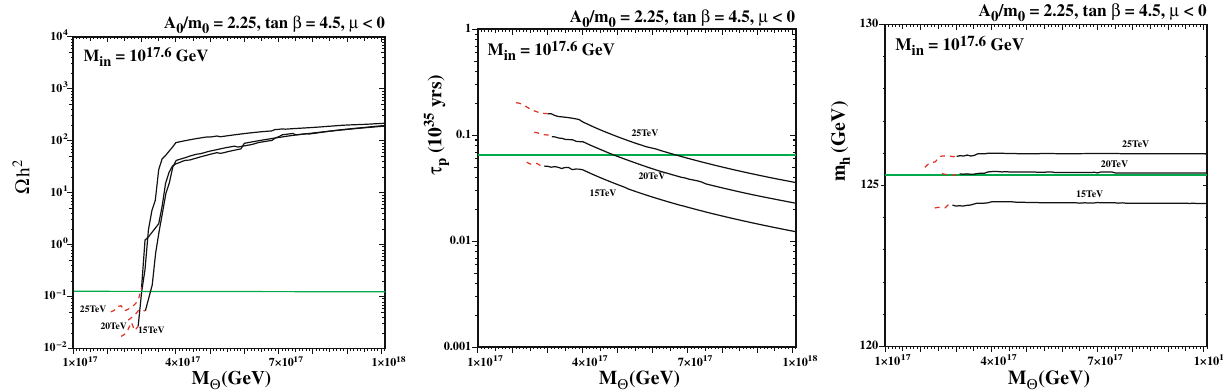
Fig. 9 As in Fig. 6, as functions of B 0 / m 0 for the indicated fixed values of m 1 / 2 ∈ [ 15 , 25 ] TeV and m 0 chosen to obtain the cosmological value of (cid:21) LSP h 2 for B 0 = A 0 − m 0 , with the same values of the other input parameters as in Fig. 3